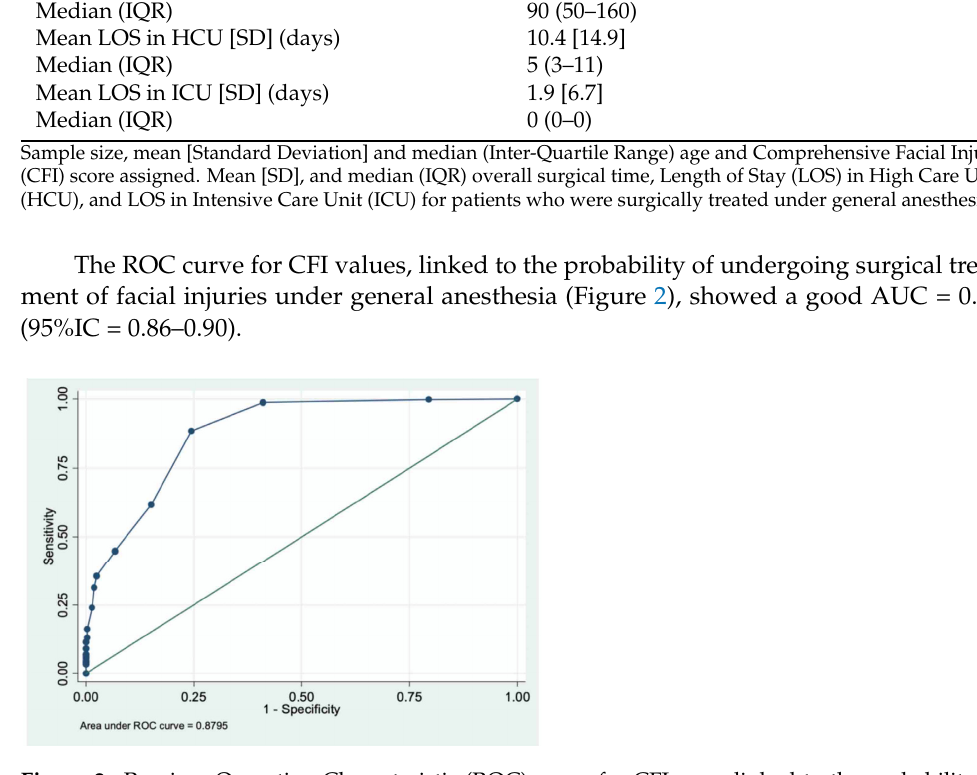
Figure 2. Receiver Operating Characteristic (ROC) curve for CFI score linked to the probability of undergoing surgical treatment of facial injuries. Area Under the Curve (AUC) = 0.88 (95%IC = 0.86–0.90).